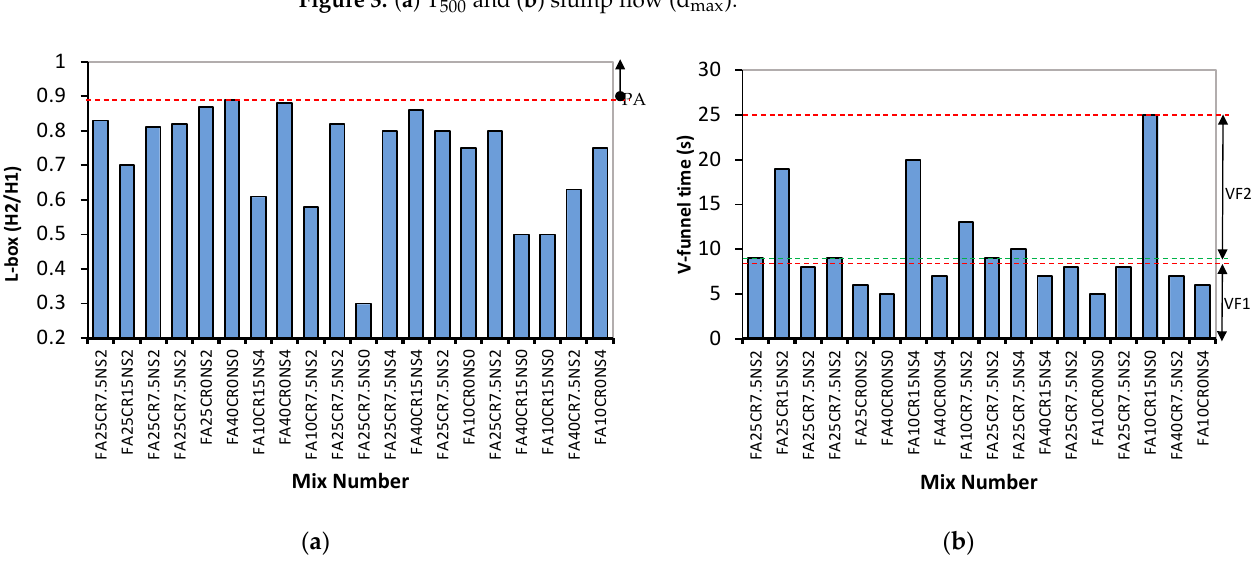
Figure 4. ( a ) L-box (passing ability) and ( b ) V-funnel.